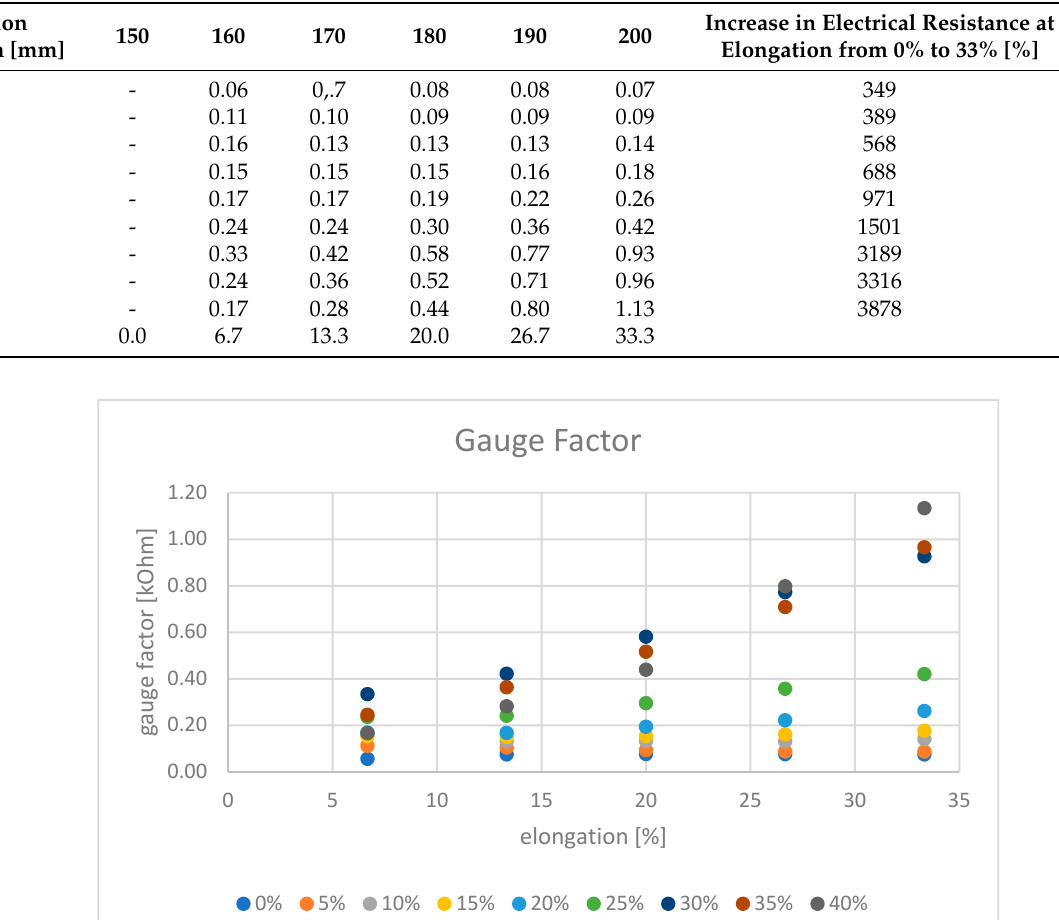
Table 5. Gauge factor as a function of strain and concentration of Ag352000 flakes.